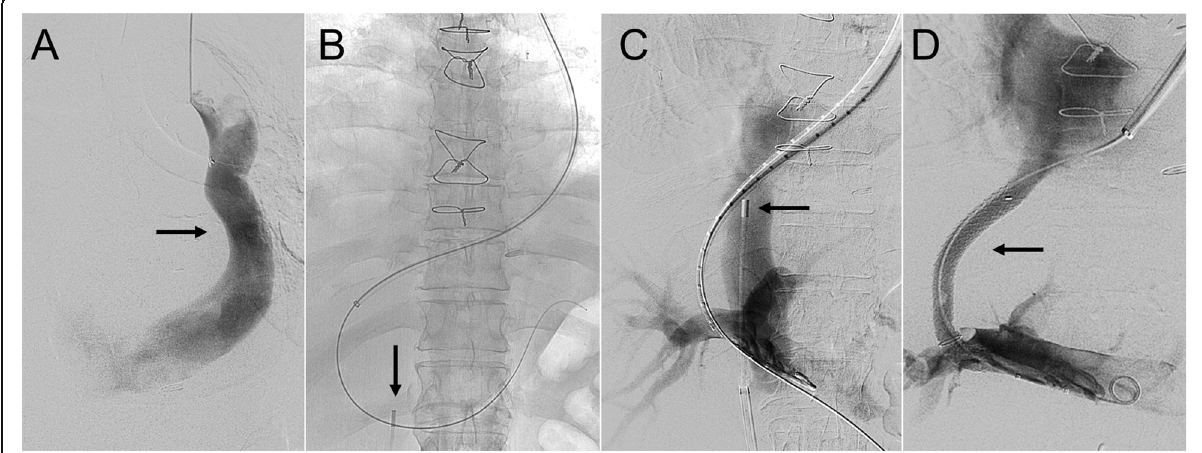
Fig. 3 A middle-aged man with hepatic hydrothorax and isolated persistent left superior vena cava. a Left internal jugular venography demonstrating the isolated persistent left superior vena cava (solid arrow). b Access from the left internal jugular vein into the portal system via the left superior vena cava and coronary sinus using intravascular ultrasound-guidance (solid arrow). c The right portal vein was accessed with a Rösch-Uchida needle, and simultaneous portal and caval venography was performed. A perpendicular-projecting intravascular ultrasound probe (solid arrow) is shown. d An 8 – 10-mm × 8-cm (covered) / 2-cm (uncovered) Viatorr controlled expansion stent-graft (solid arrow) was deployed with resultant brisk in-line